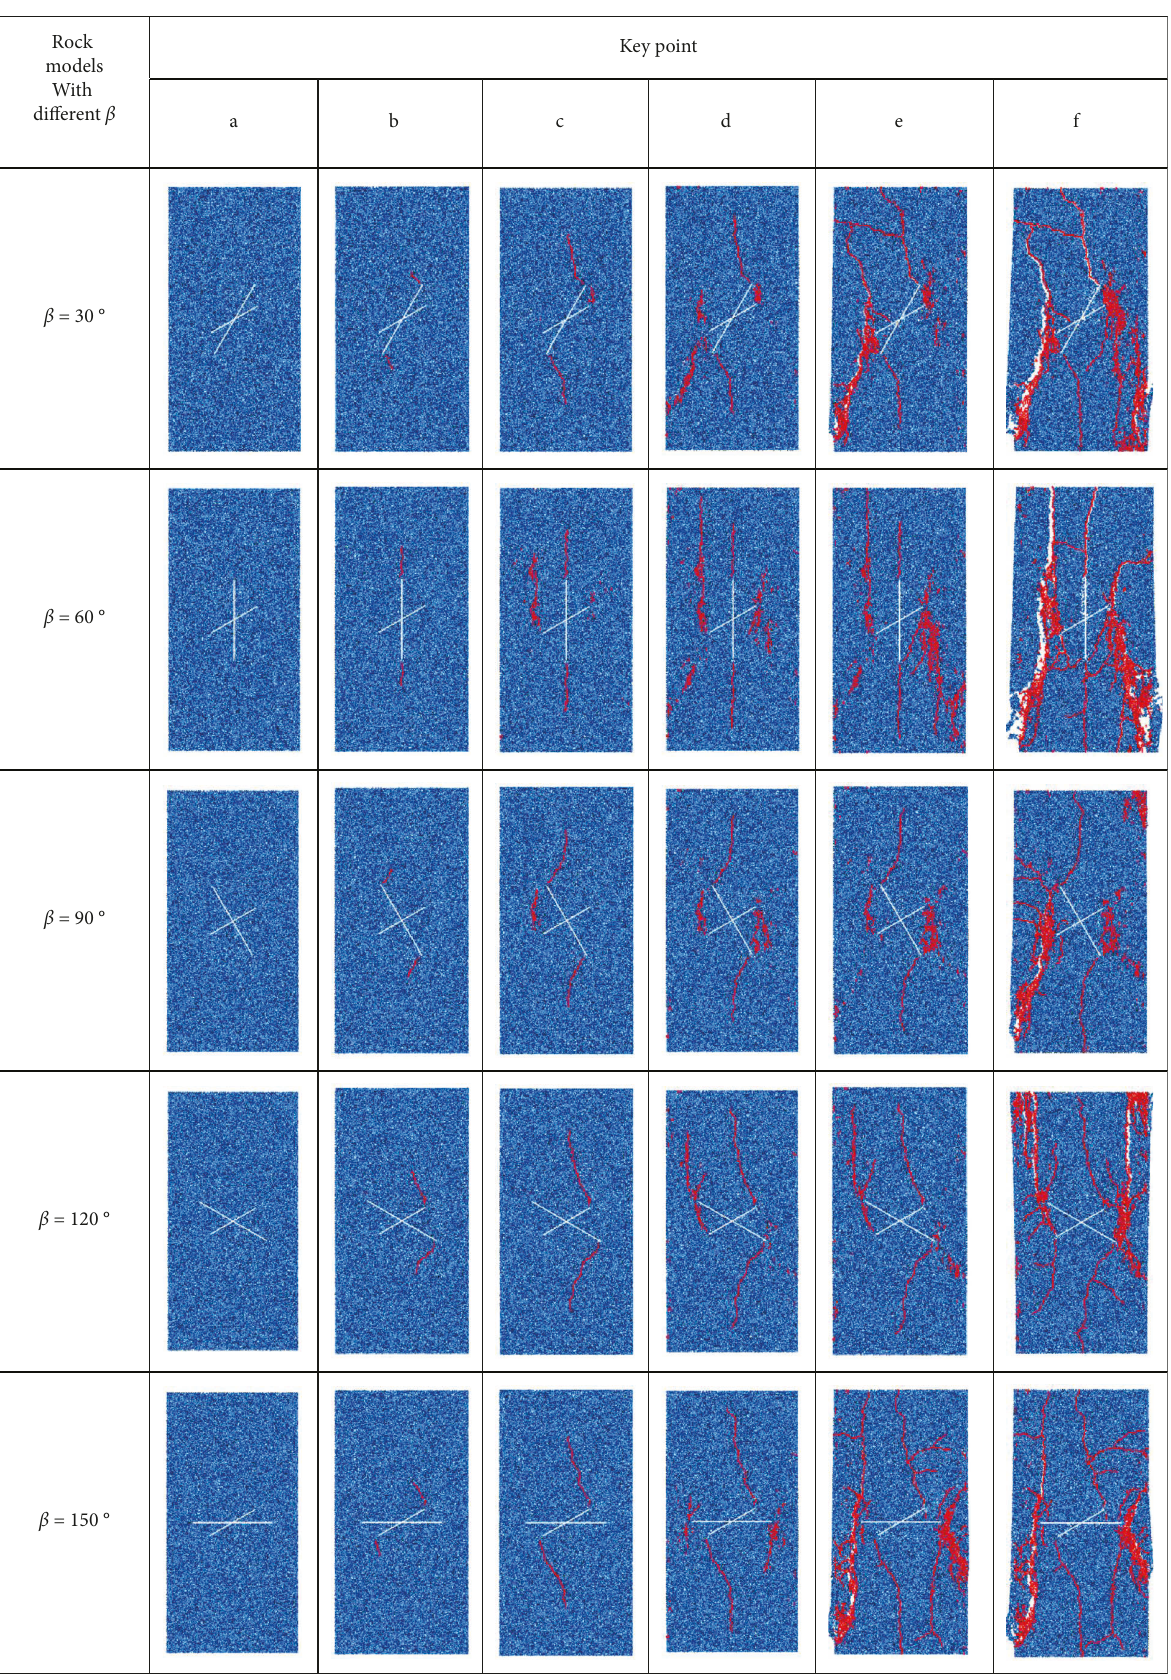
Figure 11: Damage evolution of rocks with different joint